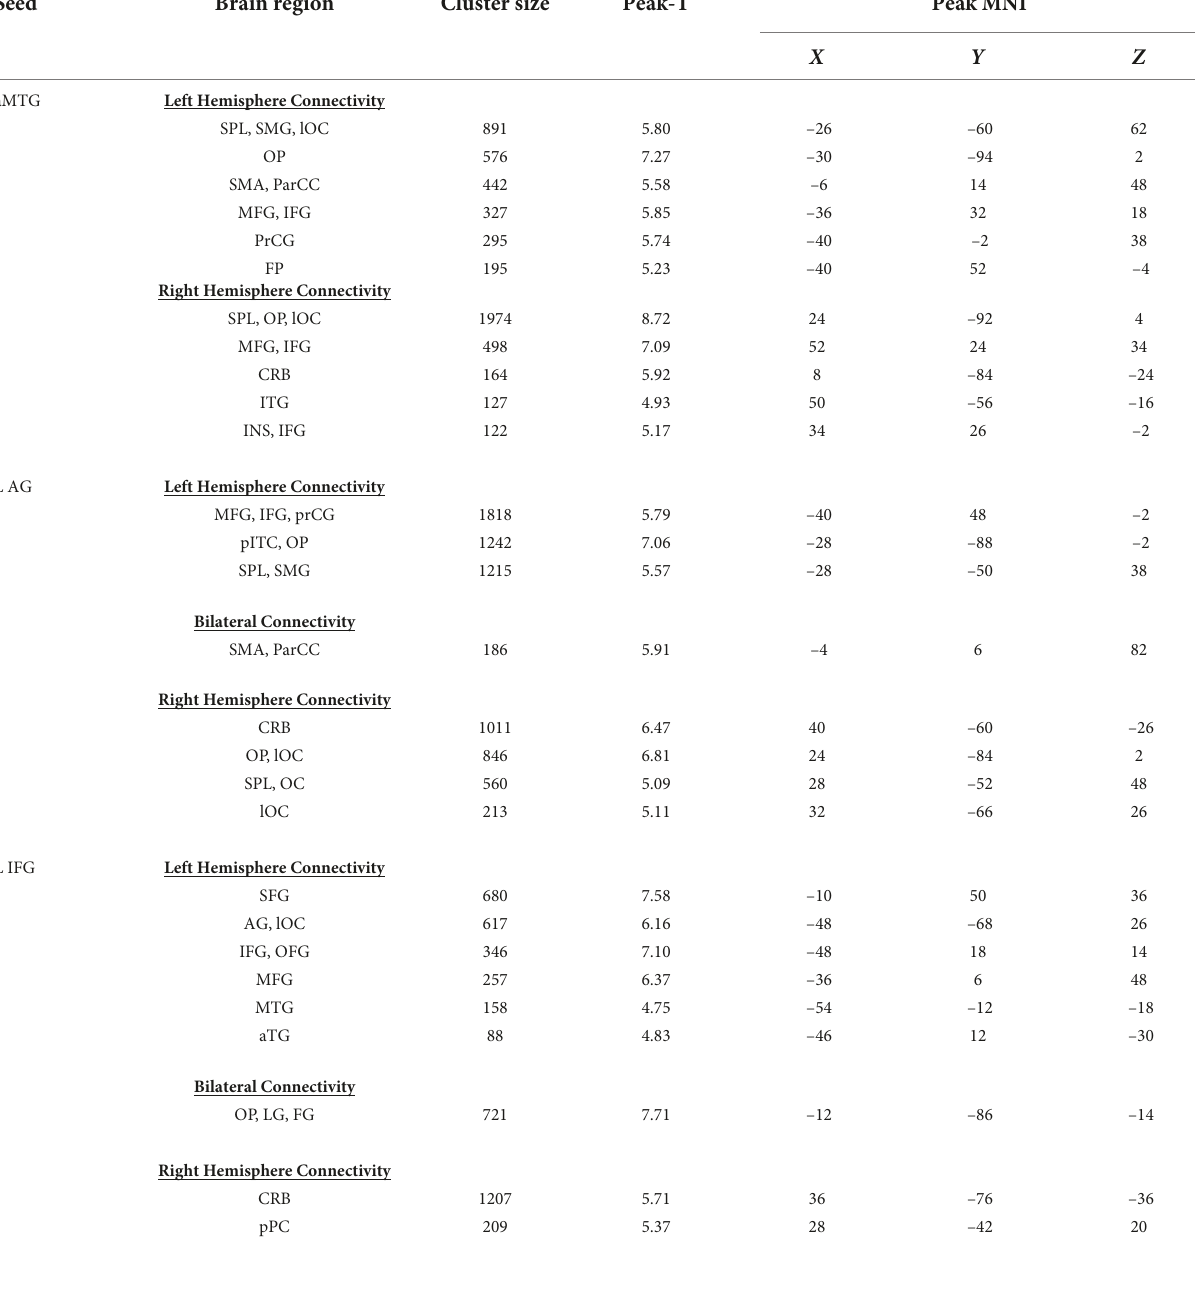
TABLE 1 Whole brain analyses of seed-to-voxel analyses for semantic processing relative to rhyme, seeding the l aMTG, l AG, and l IFG. Seed Brain